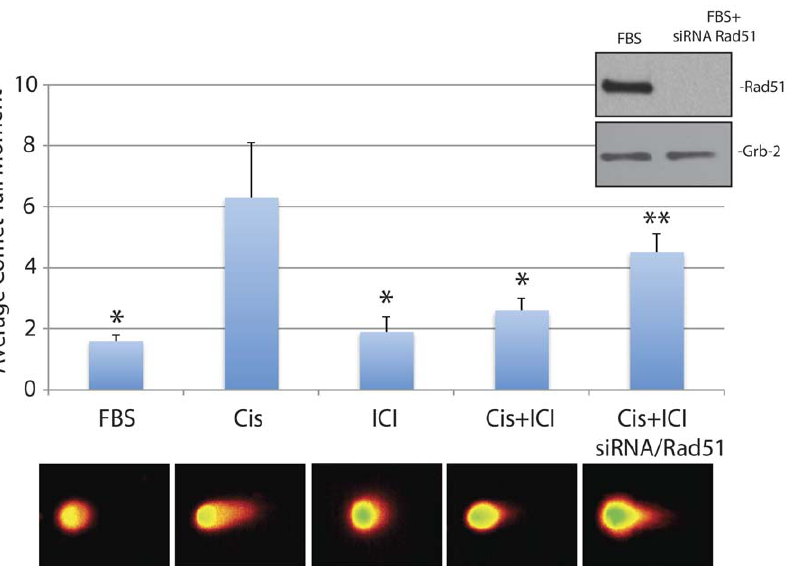
Figure 5. Inhibition of ER b decreases cisplatin-induced DNA damage. Neutral comet assay (single cell electrophoresis) of exponentially growing Daoy cells (FBS) in which cisplatin treatment (1 m g/ml for 6 hours) was applied in the absence (Cis) or in the presence of 10 m M ICI182,780 (Cis + ICI). The histogram represents average Olive tail moment (with standard deviation) calculated from three experiments in duplicate (n=6). In each experiment at least 100 cells were selected for the calculation (Automated Comet Assay; Loats Associates. Inc.). * indicates value statistically different from the sample labeled Cis. ** indicates value statistically different form Cis + ICI (paired student t-test; P # 0.05). Inset: Western blot showing effectiveness of Rad51 siRNA (100 nM for 48 hrs) tested in exponentially growing Daoy cells.